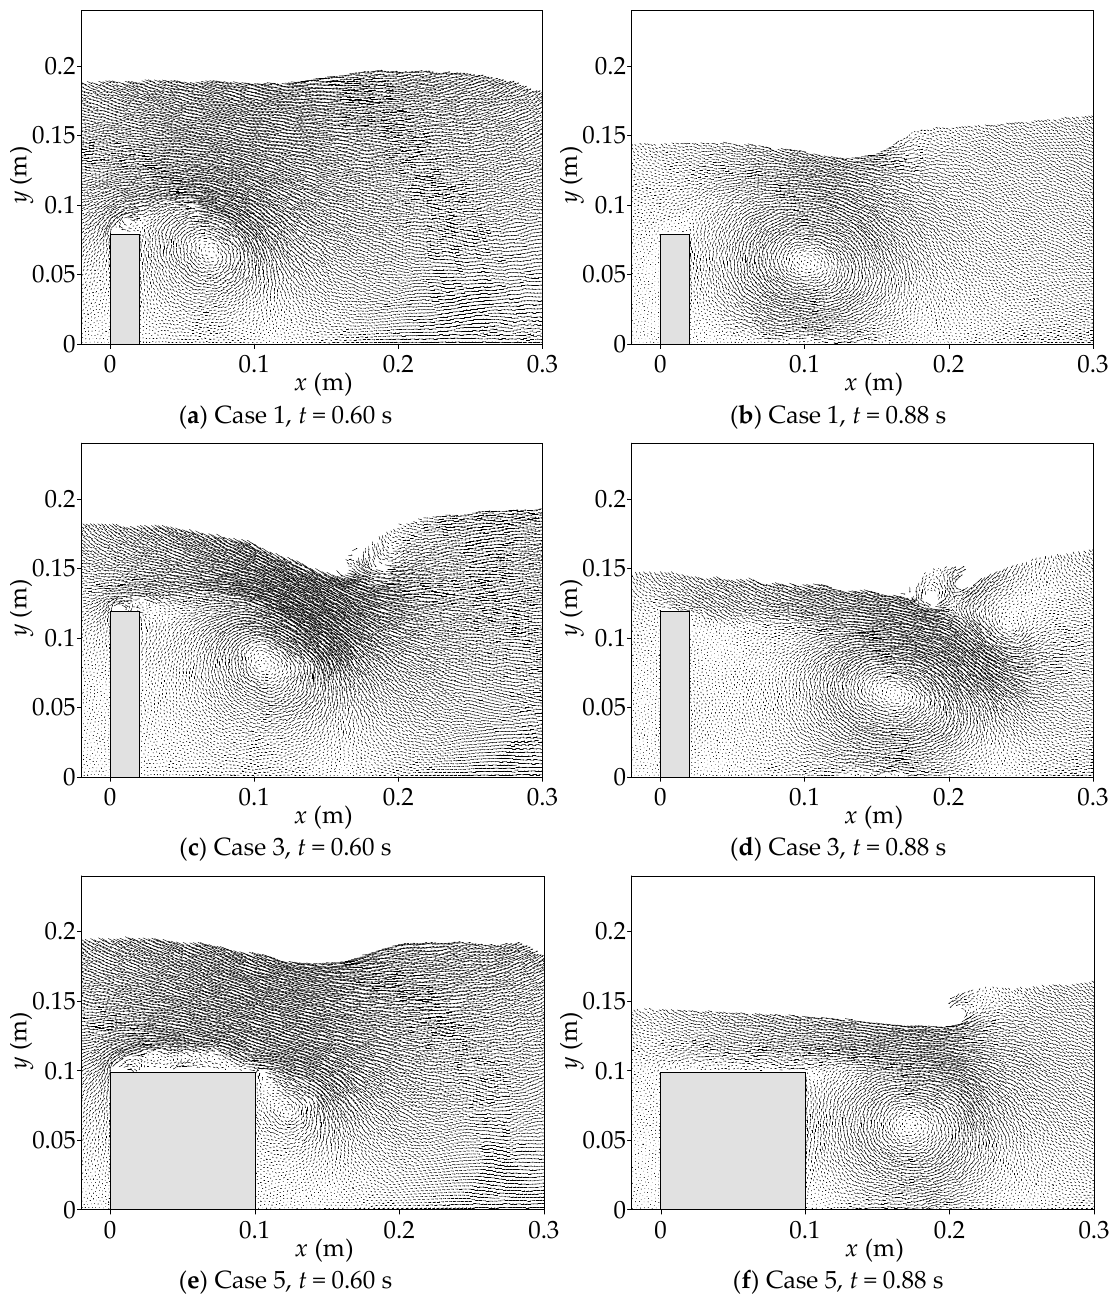
Figure 10. Velocity fields of cases 1, 3 and 5 at t = 0.60 s and t = 0.88 s: ( a ) Case 1, t = 0.60 s; ( b ) Case 1, t = 0.88 s; ( c ) Case 3, t = 0.60 s; ( d ) Case 3, t = 0.88 s; ( e ) Case 5, t = 0.60 s; ( f ) Case 5, t = 0.88 s.